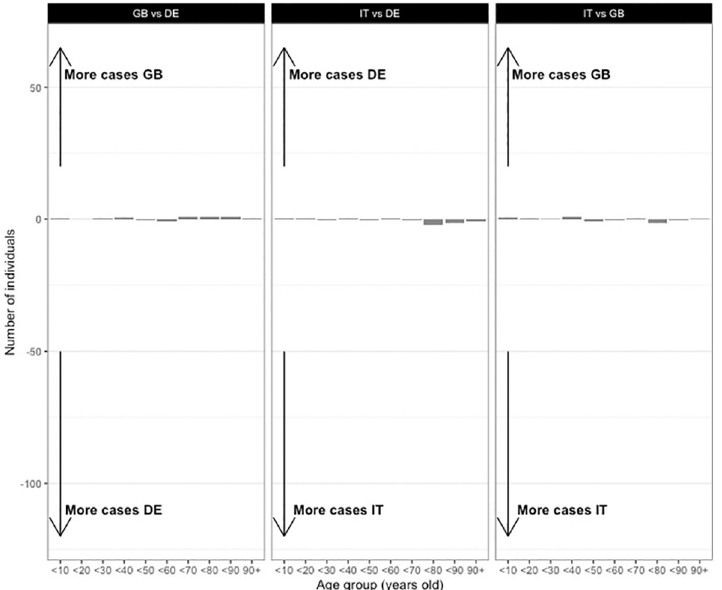
Fig 4. Effects of age mix on the average number of infected individuals across age groups. Dyadic contagion probability p = 0.05. Differences in the average number of infected individuals across 10-year age groups at the end of the simulation runs, attributable to differences in age mix only . All networks have the population age structure and the degree distribution of Italy. Left panel compares Great Britain with Germany; central panel Germany with Italy; right panel Great Britain with Italy. The x-axis represents equality: both networks have the same number of infected individuals.